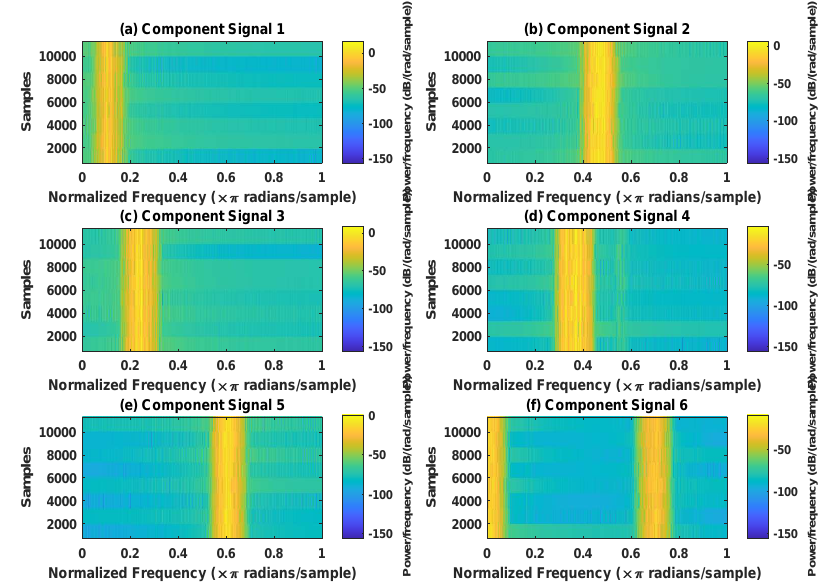
Figure 20. Decomposition results of FESVDP with m = 16 and J = 3: ( a – f ) time–frequency diagram of 1st to 6th subcomponents, respectively.